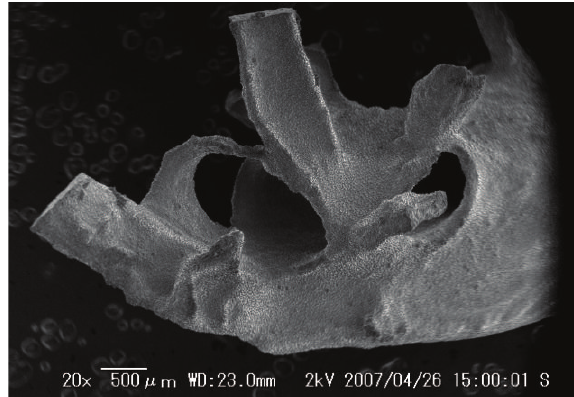
Figure 11: SEM image of Paracorallium japonicum with a commen- sal nest bored into the axis; OCA-Cn20051219-023.